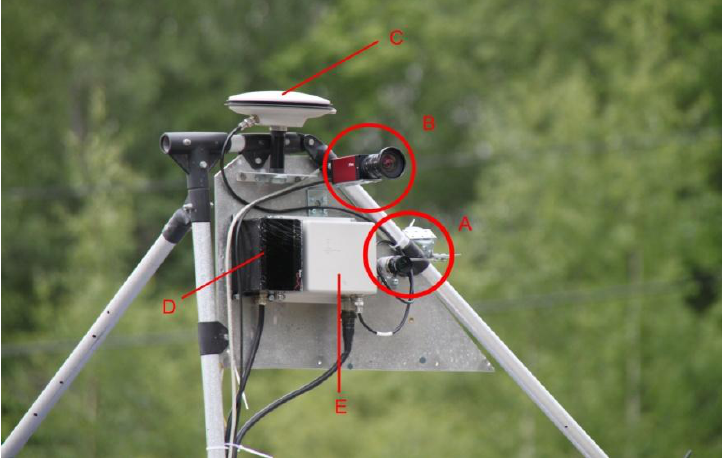
Figure 1. The Sensei measurement system in its mobile mapping configuration mounted on a car. The sensors are as follow: ( A) . A Specim V10H line spectrometer and a mirror for viewing the Spectralon TM reference panel (not shown in figure); ( B) . An AVT Pike F-421C CCD camera (not used in this study); ( C) . A Novatel 702 GG GPS receiver;